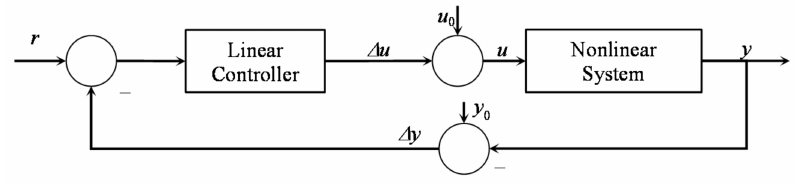
Figure 4. Control system configuration for a nonlinear system with a linear controller.